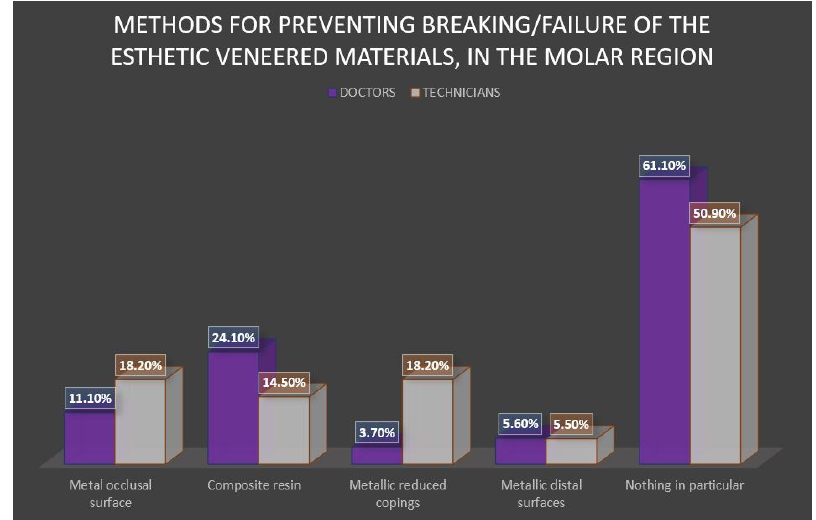
Figure 7. Methods for preventing breaking/failure of the esthetic plating materials, in the molar region.